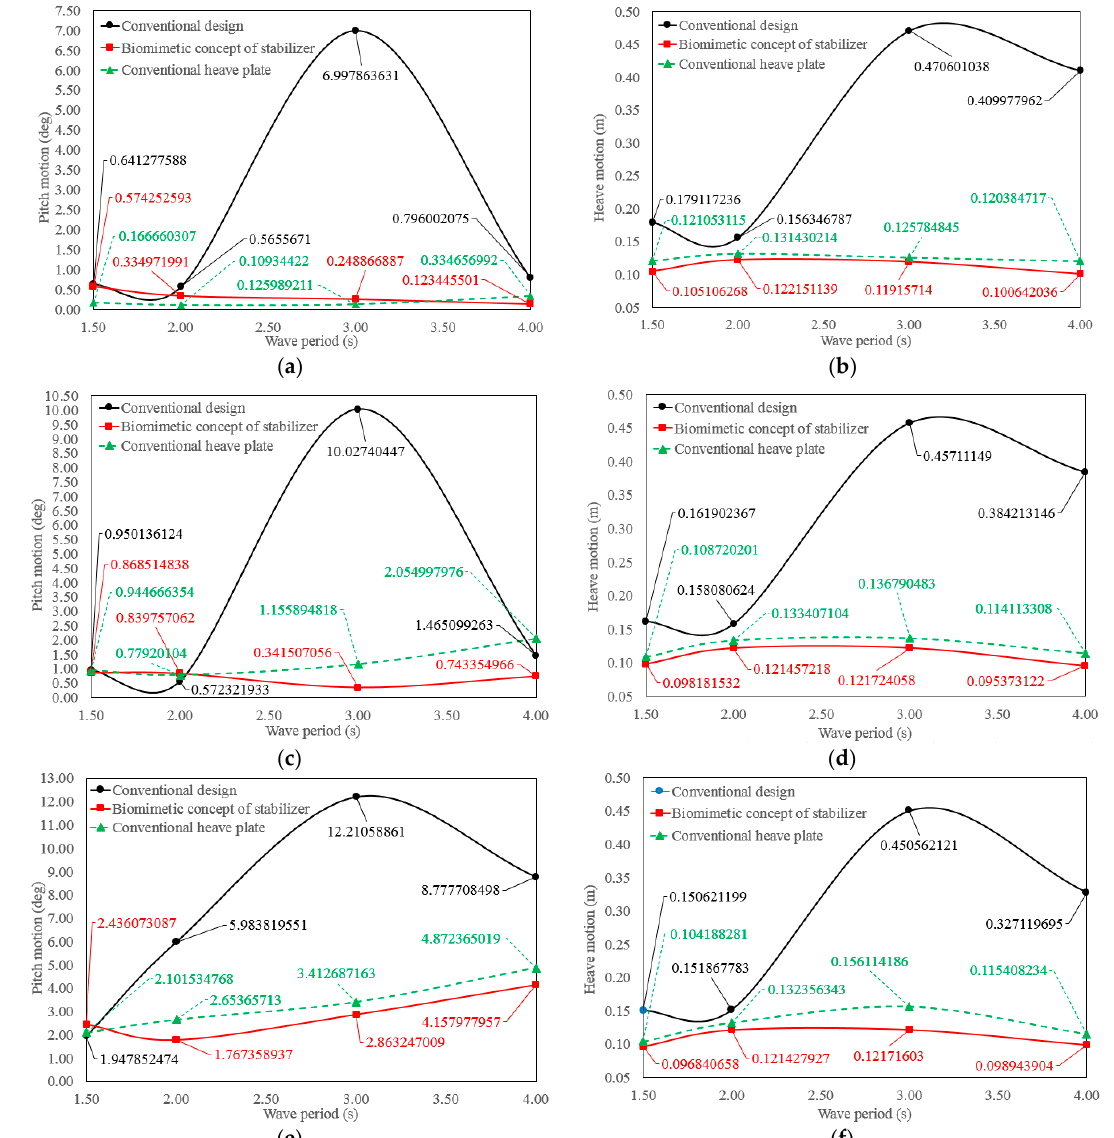
Figure 9. Measured pitch and heave motions of the floating wind turbine. ( a ) Pitch under pure wave conditions; ( b ) heave under pure wave conditions; ( c ) pitch under wave–current conditions; ( d ) heave under wave–current conditions; ( e ) pitch under wind–wave–current conditions; and ( f ) heave under wind–wave–current conditions.